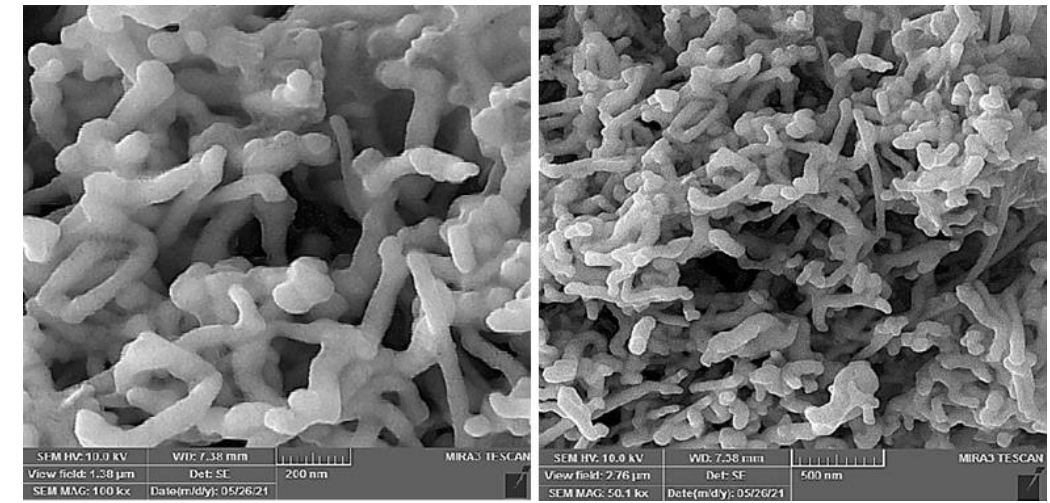
Fig. 3. SEM of Ag Fig. 3. SEM of Ag nanostructures